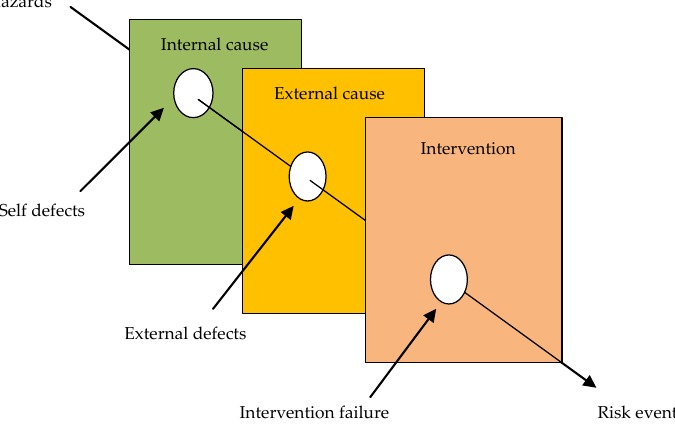
Figure 6. “Swiss Cheese” model of safety behavior risk of the train operation